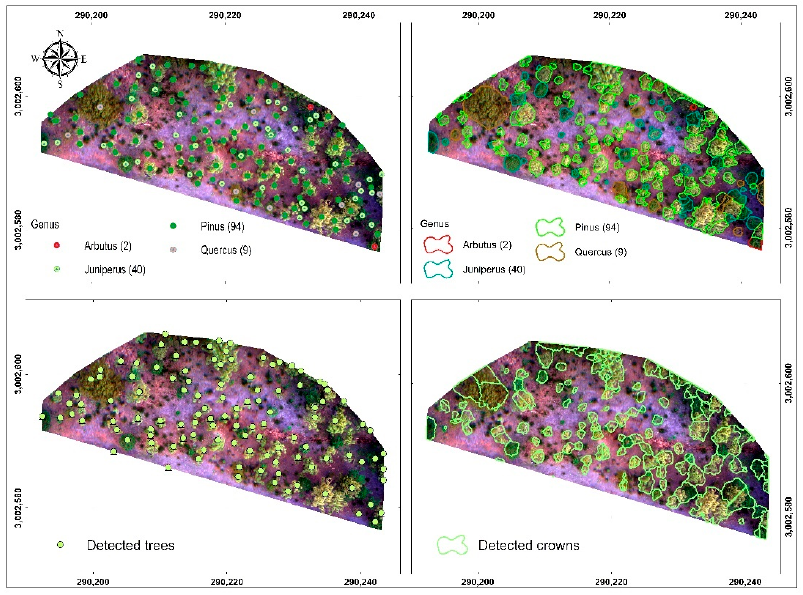
Figure 4. Digitalization of trees ( top left ), digitalization of crowns ( top right ), trees identified ( bottom left ) and crowns detected ( bottom right ) using the ForestTools algorithm.